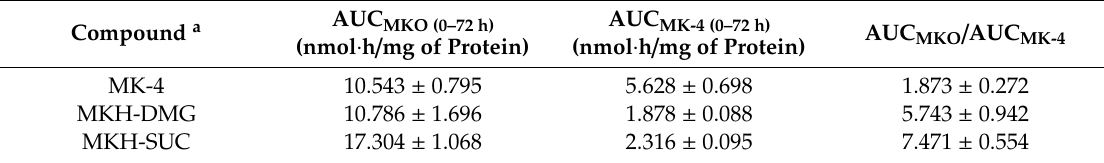
Table 3. The area under curve over 72 h (AUC MKO (0–72 h) ) of MKO and (AUC MK-4 (0–72 h) ) of MK-4 concentrations and the AUC ratio of MKO to MK-4 (AUC MKO / AUC MK-4 ) over time in HaCaT cells treated with MK-4 or MKH derivatives. Compound